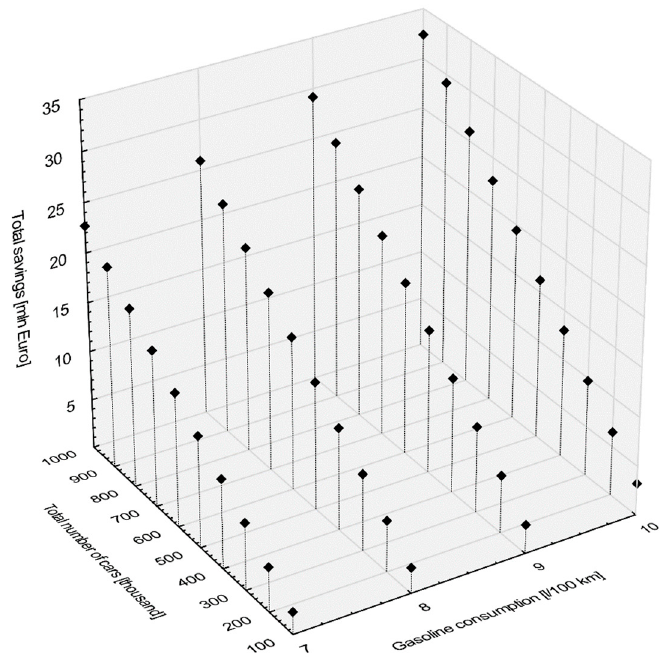
Figure 12. The total monetary savings in millions of Euro per year for energy-saving engine oil use case.